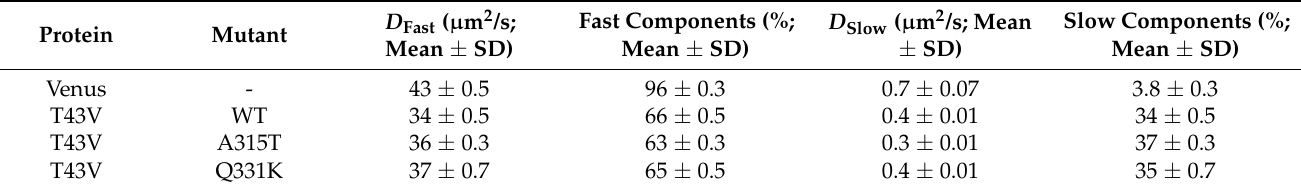
Table 2. Comparison of the diffusion coefficient and calculated molecular weight of fluorescent protein-tagged wild type (WT) and ALS-associated mutants (A315T and Q331K) of TDP-43 tagged with mTFP1 and Venus (T43V) for FRET measurement in Neuro2a